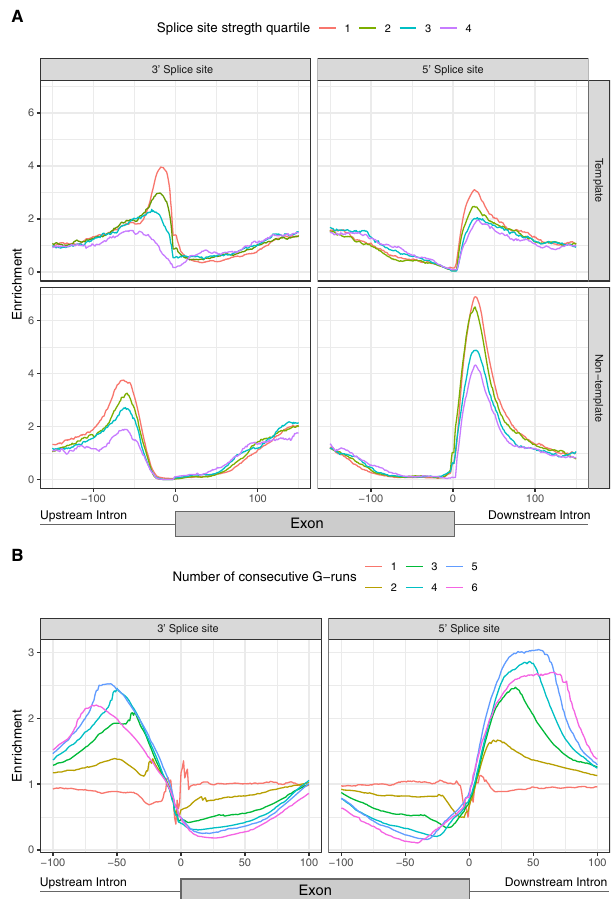
Fig. 2 Characterisation of DNA G4 positioning across splicing junctions. A G4 enrichment for template and non-template strands and strati fi ed by the splicing strength scores of the adjacent splice site. The splicing strength scores for splice junctions with a G4 are signi fi cantly lower than for splice junctions without a G4 (Mann – Whitney U , p value <0.001). The splicing strength score bias was found to be dependent on the strand orientation of G4s for splice sites with G4s within 100 nt away (Mann – Whitney U , 3 ′ ss p value <0.05, 5 ′ ss p value <0.001). B Number of consecutive G-runs and relative enrichment at the splicing junction. The error bands in A , B represent 95% con fi dence intervals from the binomial